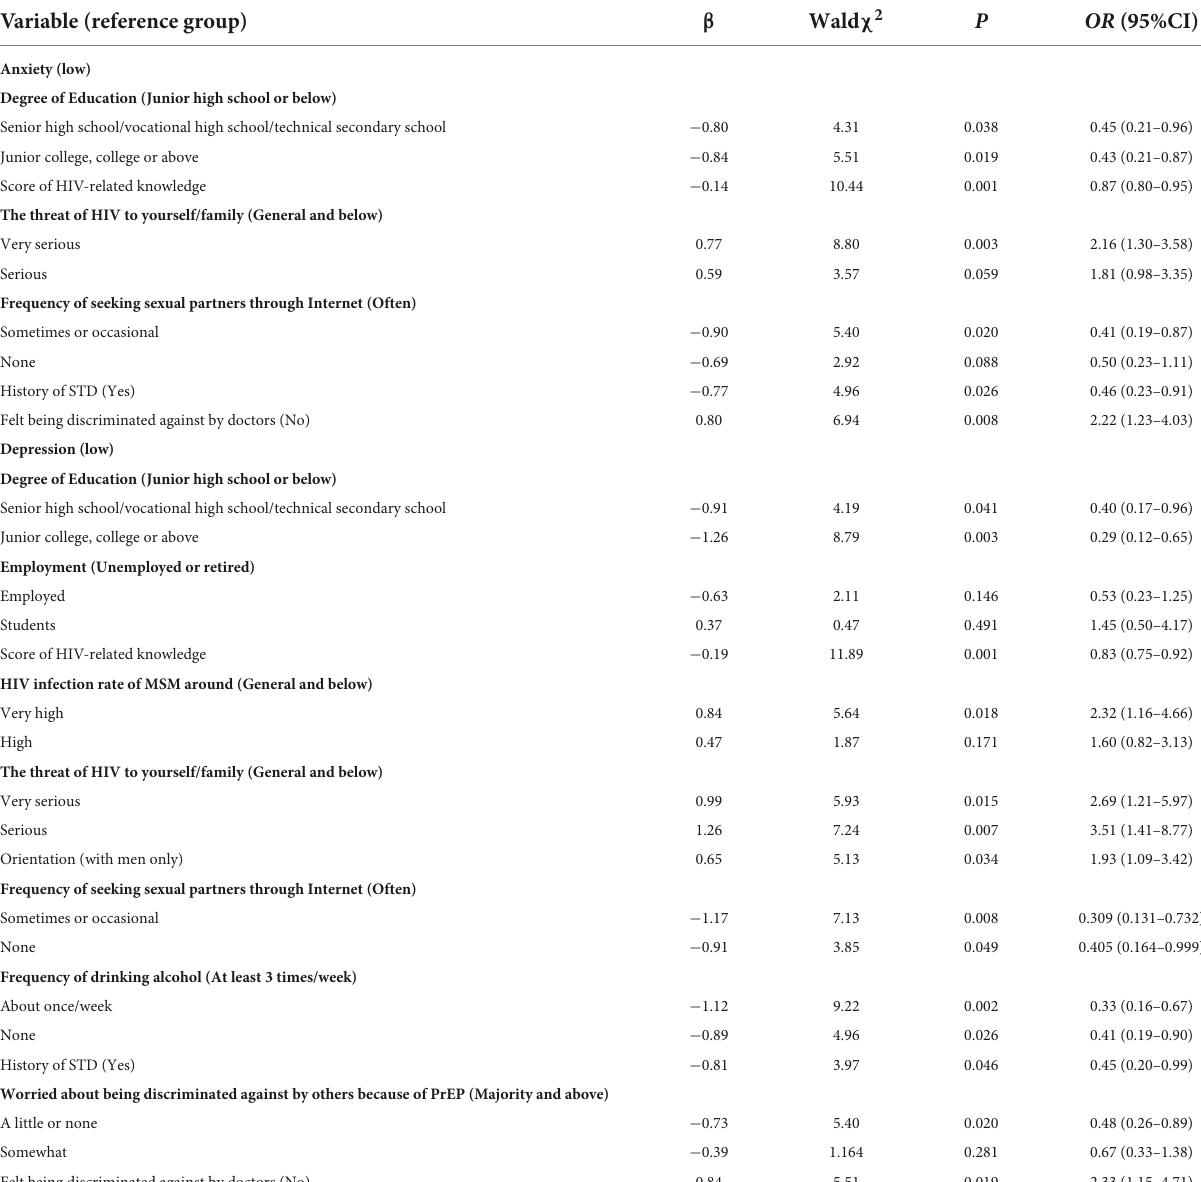
TABLE 6 Multivariate analysis of anxiety and depression among men who have sex with men (MSM). Variable (reference group) β Wald χ 2 P OR